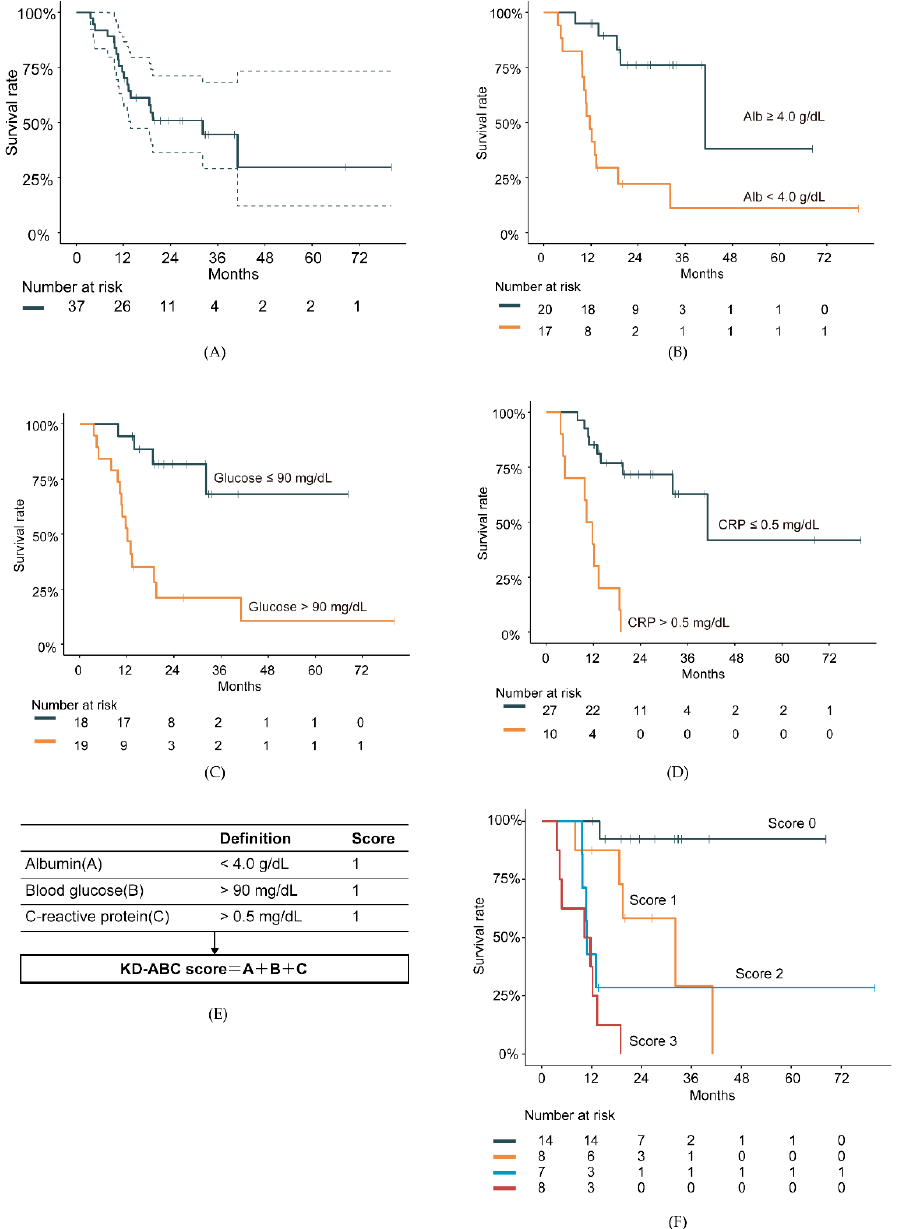
Figure 5. Cumulative survival rates of patients on the ketogenic diet. ( A ) Continuous line shows overall survival of 37 patients. Dotted lines indicate 95% confidence intervals. ( B ) Patients with serum values for albumin (Alb) ≥ or < 4.0 mg/dL ( p < 0.001); ( C ) glucose (Glu) > or ≤ 90 mg/dL ( p < 0.001) and ( D ) C-reactive protein (CRP) > or ≤ 0.5 mg/dL ( p < 0.001). ( E ) Diagram of the ketogenic diet-ABC (KD-ABC) score calculation method. ( F ) KD-ABC scores significantly stratify cumulative survival rates ( p < 0.001). All p values determined by log-rank